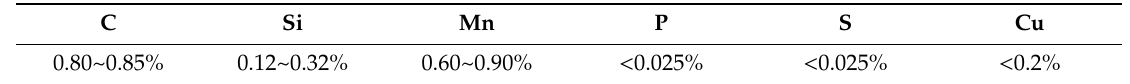
Table 1. Chemical composition of S82B.